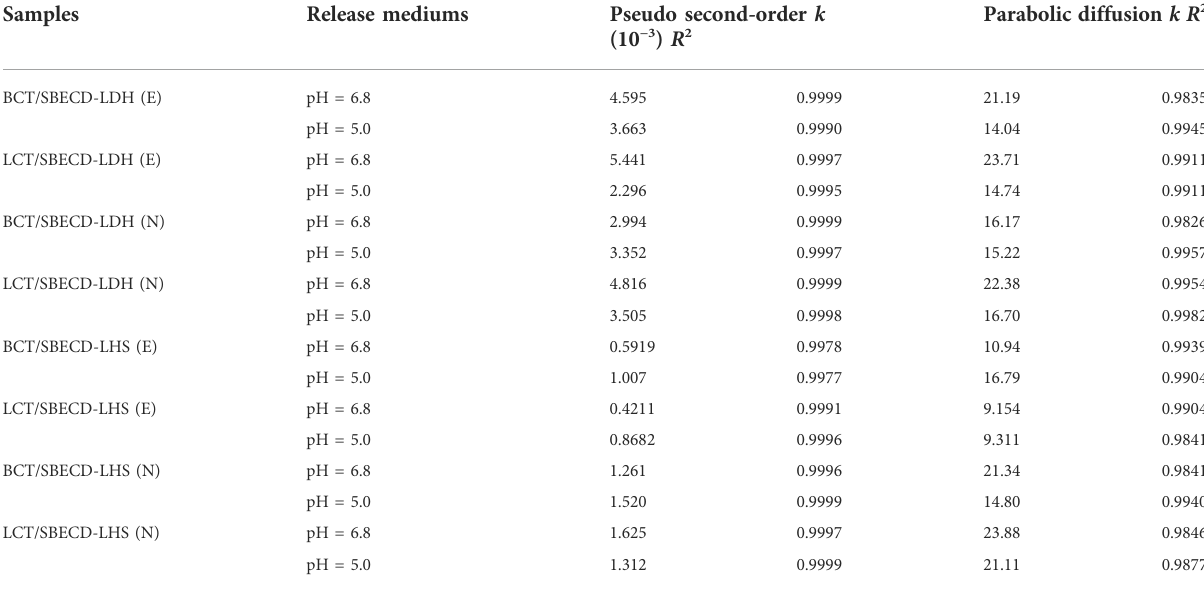
TABLE 2 Kinetic parameter of different hybrids in pH = 5.0 and = 6.8